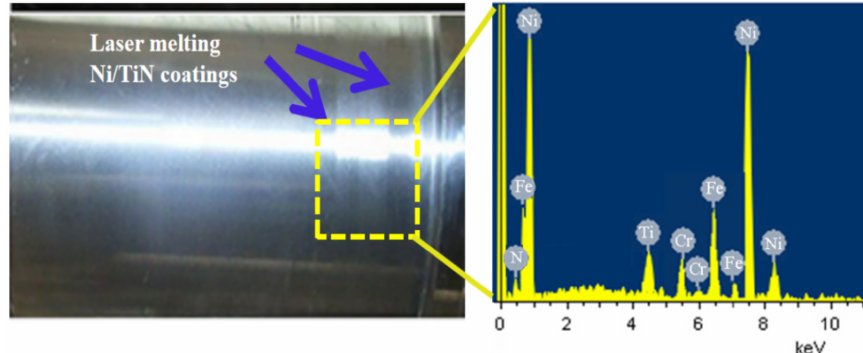
Figure 9. Image of the shaft of the ESP after repair by using LMD